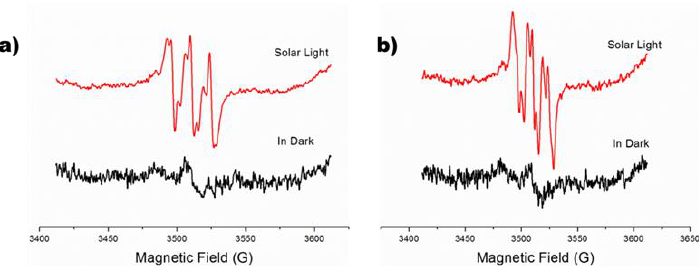
Figure 5. ESR spectra of ( a ) FAPbBr 3 and ( b ) 20% FAPbBr 3 /C 3 N 4 hybrids.